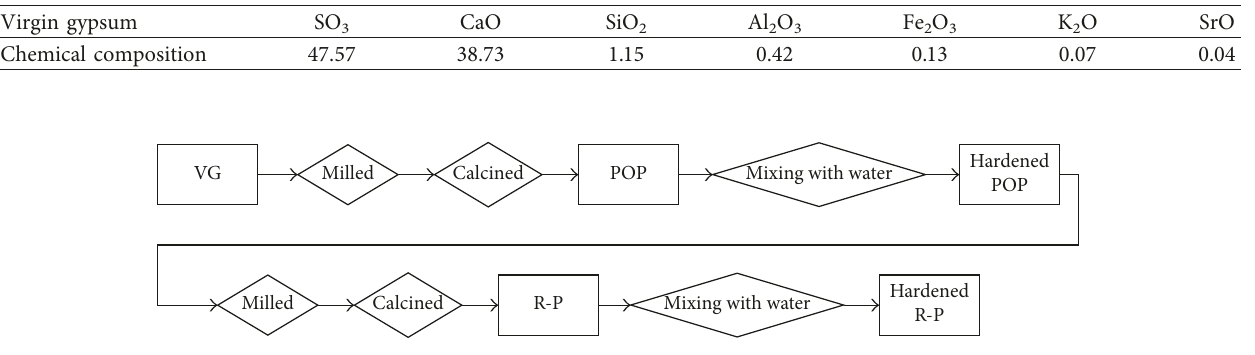
Figure 1: The flowchart of preparing R-P and its hardened R-P. Table 2: Properties of POP and R-P under the similar